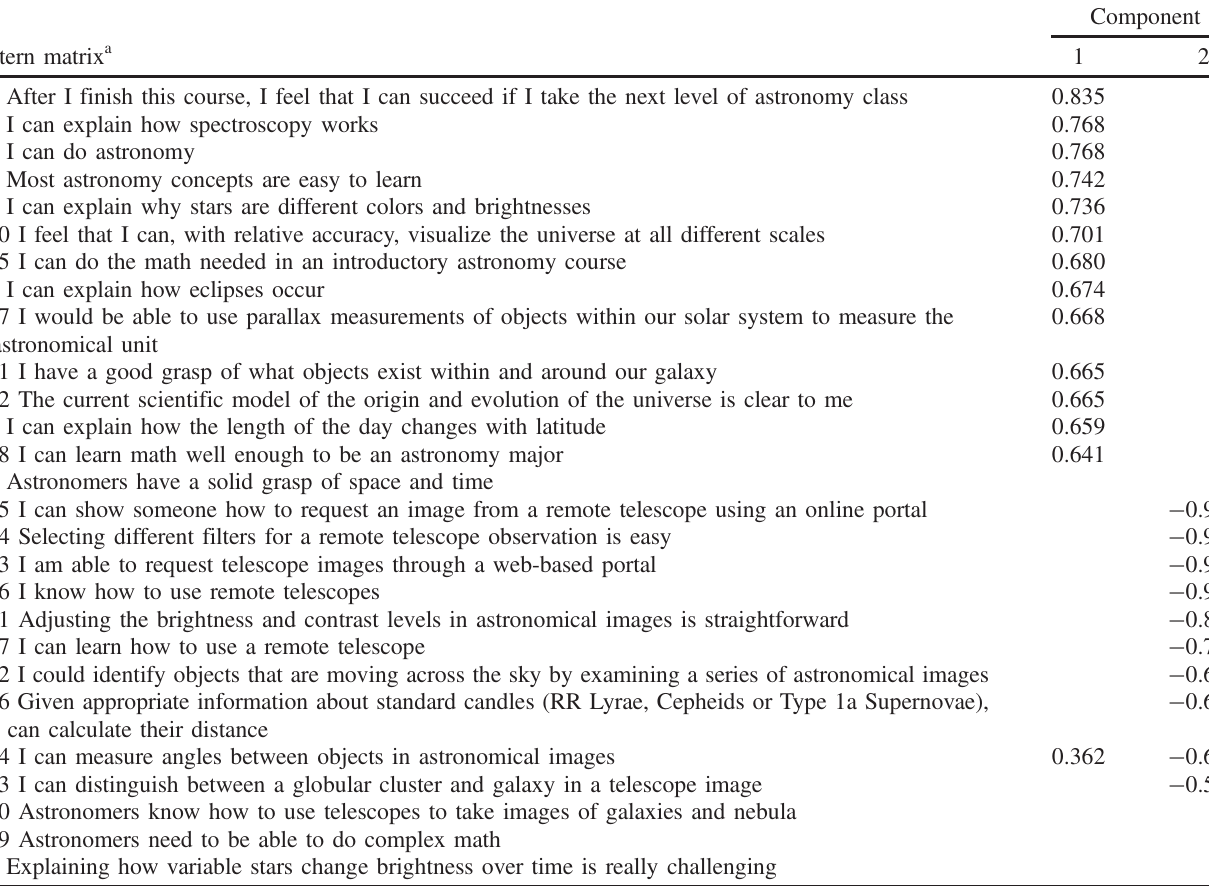
TABLE I. Pattern matrix from principal component analysis constrained to two factors.